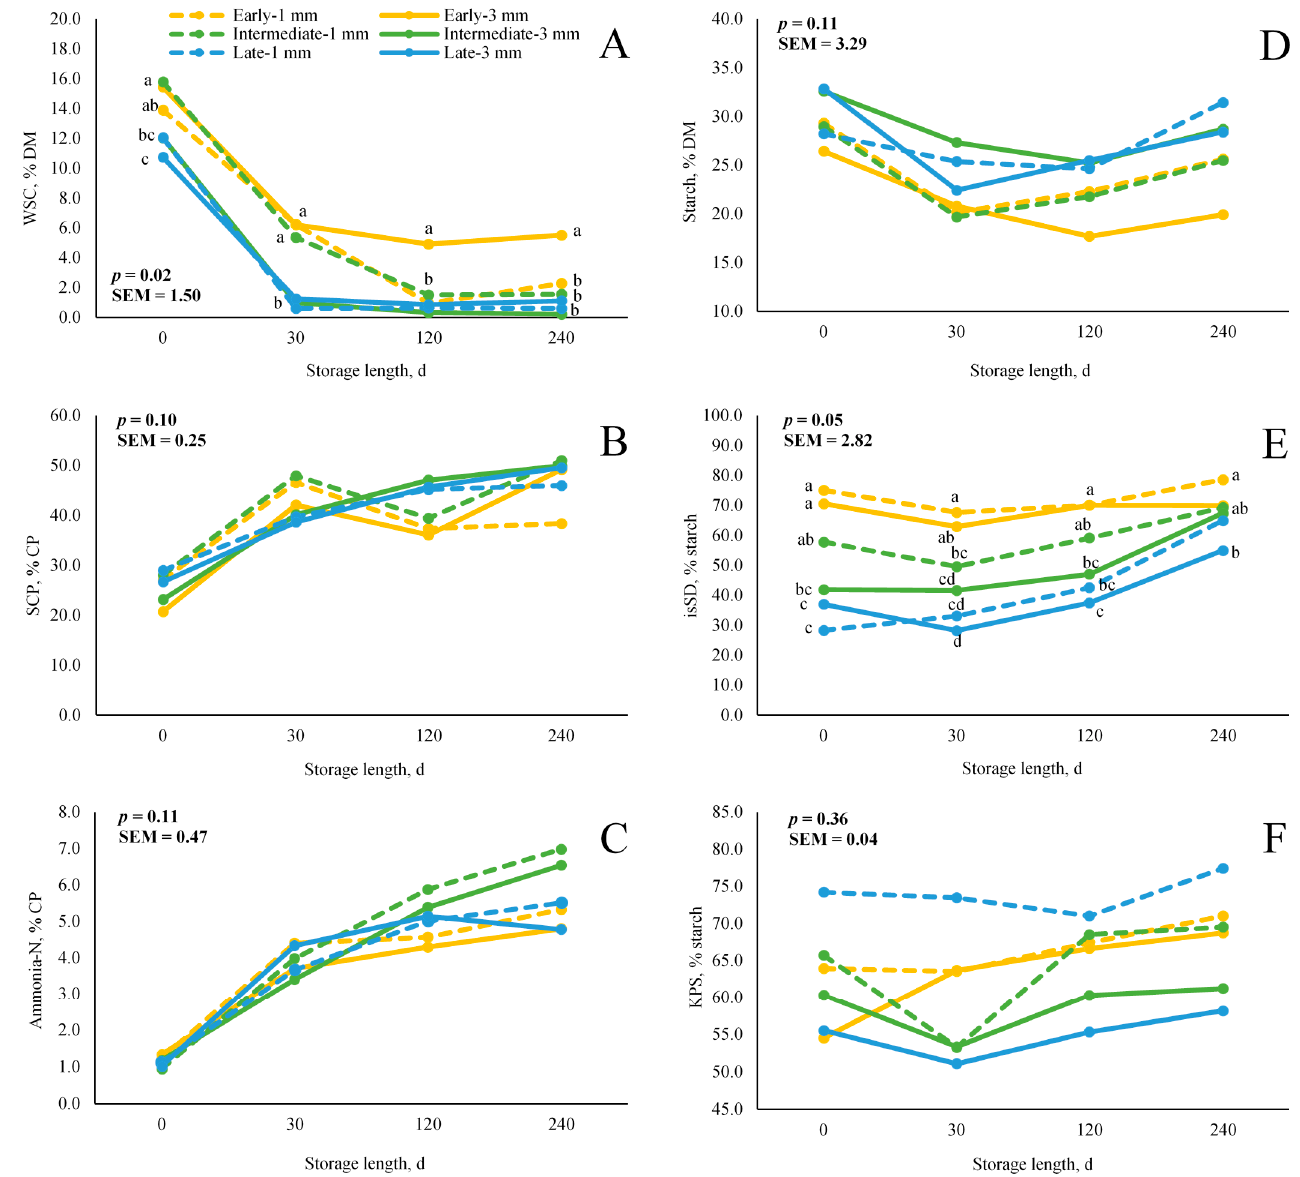
Figure 2. The effect of maturity, roll gap width, and storage length on WSC ( A ), SCP ( B ), ammonia-N ( C ), starch ( D ) concentrations, as well as isSD ( E ) and KPS ( F ) of whole-plant maize silage ( n = 96). Means within the same day with different letters (a,b,c) differed ( p ≤ 0.05). Whole-plant maize was harvested at 3 maturities (1/4 (Early), 1/2 (Intermediate), and 3/4 (Late) kernel milk line) and processed through rolls with a gap width of either 1 or 3 mm using a self-propelled forage harvester. Silage was stored for 0, 30, 120, or 240 d.